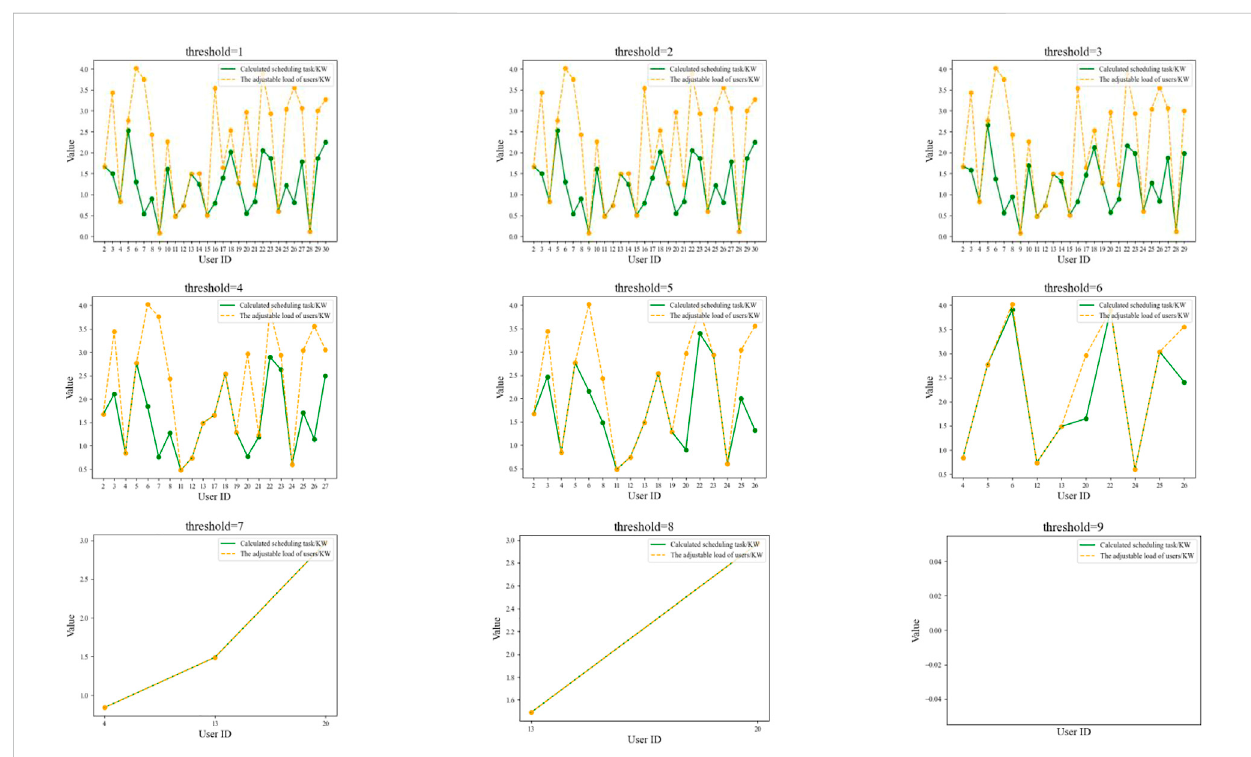
FIGURE 7 Comparison between scheduling tasks and adjustable load of users with different load elastic coef fi cient threshold ( threshold ∈ [ 1 , 9 ]